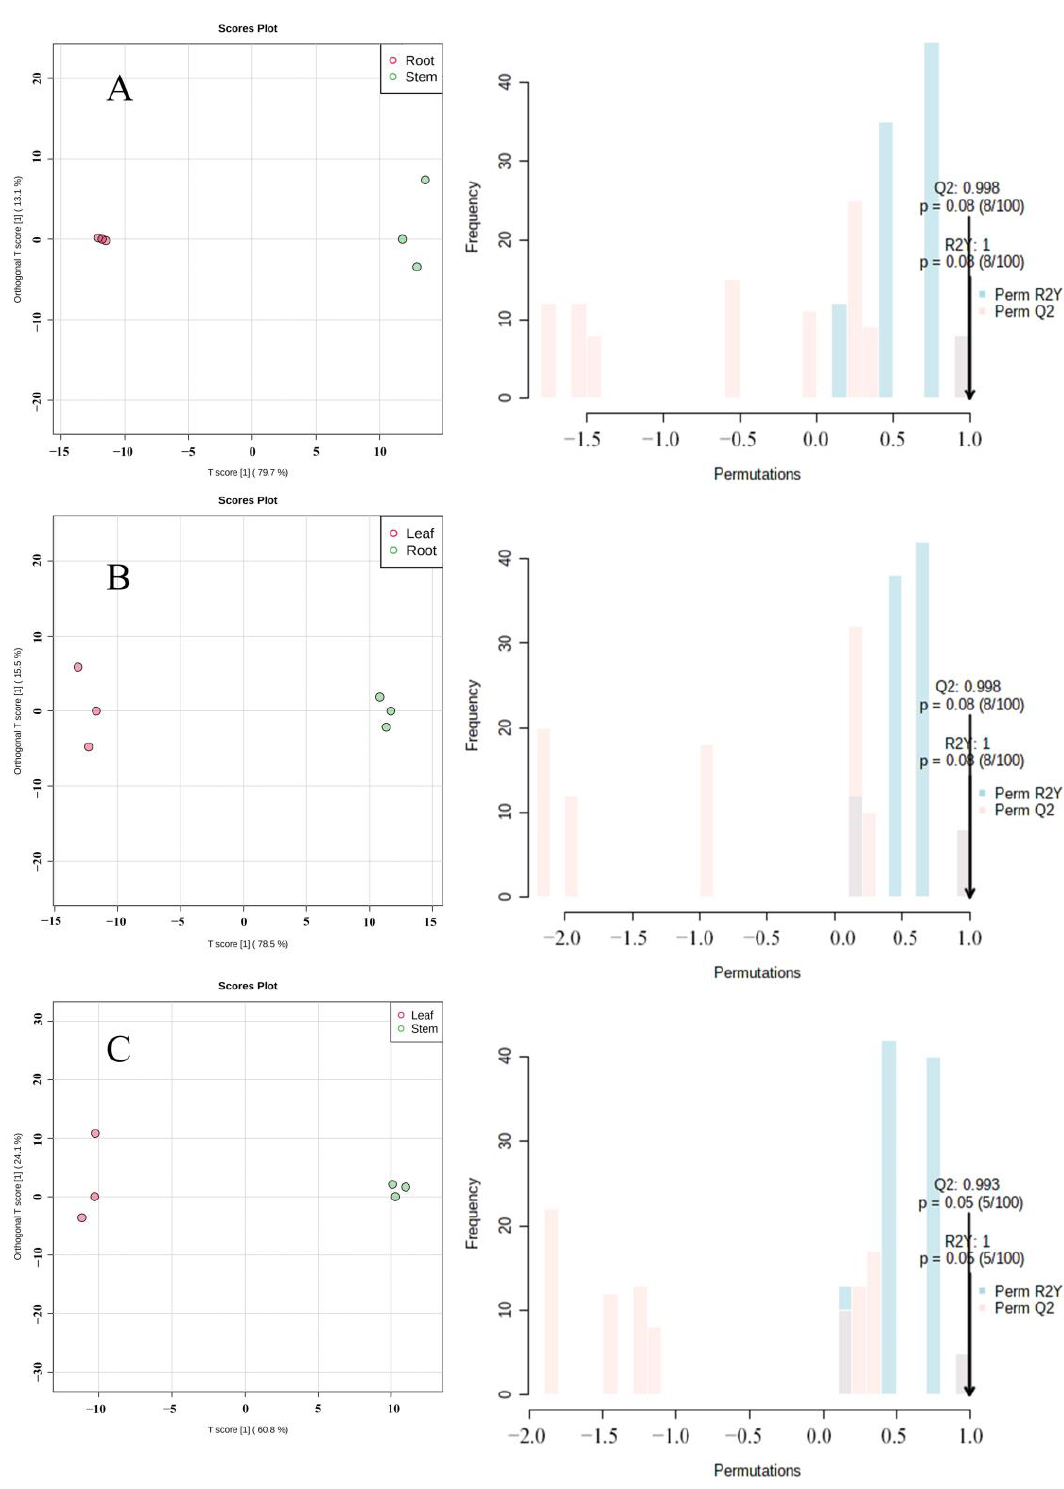
Figure 6. Orthogonal partial least squares regression analysis (OPLS-DA) score chart and 100 response ranking tests. ( A ) Root vs. stem; ( B ) root vs. leaf; ( C ) leaf vs. stem.